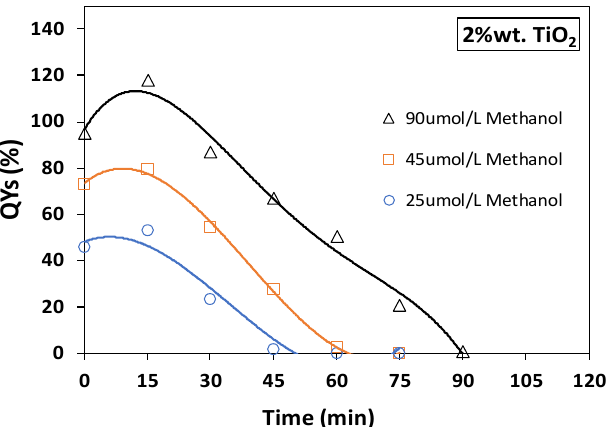
Figure 11. Quantum yield efficiencies (QYs%) for photocatalytic methanol degradation using a 2 wt.% bare-TiO 2 photocatalyst coated on a mesh. Experiments were carried out under near-UV light at three different initial methanol concentrations of 25, 45 and 90 µmol/L. Note: Reported data are for at least three repeats with 8 ± 1% SD.